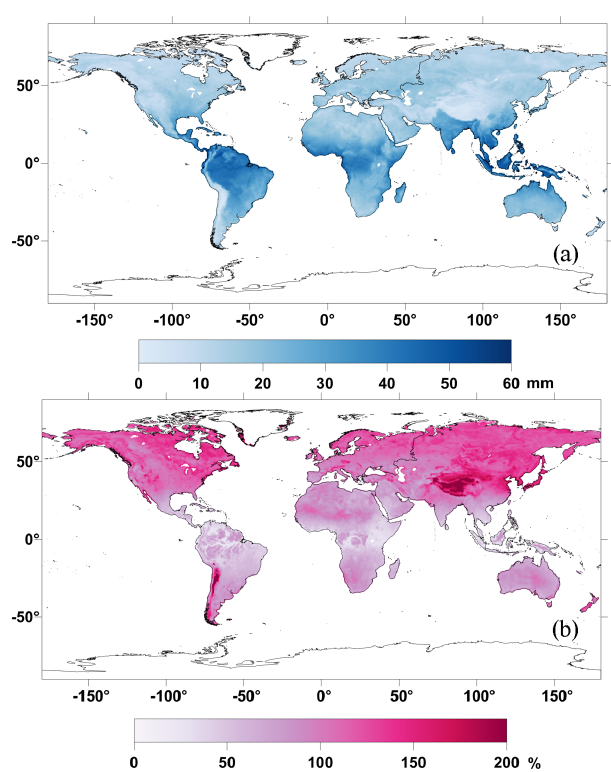
Figure 4. LPDR PWV climatology mean (a) and 2 times the coeffi- cient of variation (b) from the combined 2003–2010 and 2013–2015 record.